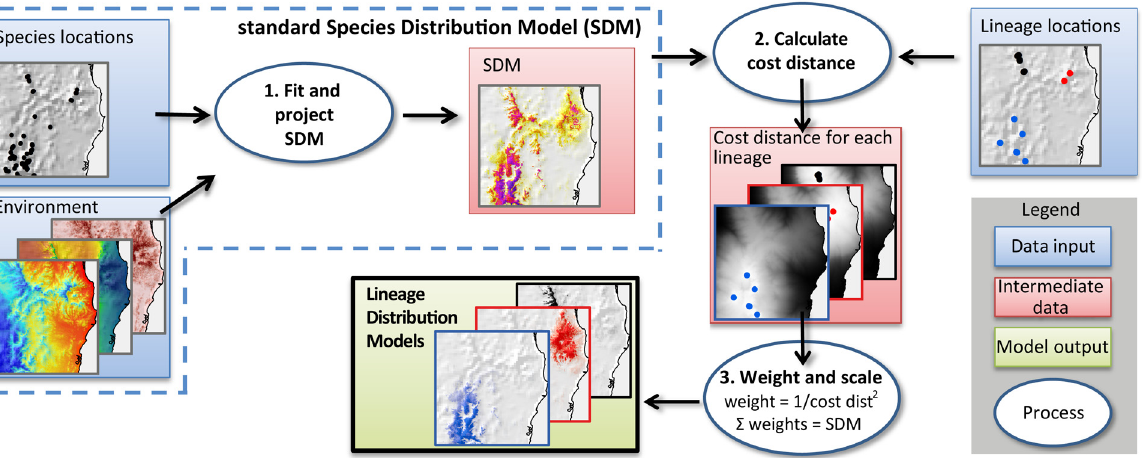
Fig 2. Steps in the lineage distribution model (LDM) method. First a species distribution model is fitted, using established methods (step 1). Then, a cost distance calculation is used to determine, for each pixel, its connection through suitable habitat to known locations of each lineage (step 2). Finally, the cost distance is turned into a weight, and scaled so that for each pixel, the weights for the lineages sum to the species model suitability (step 3). In effect, the species model is partitioned among the known lineages in proportion to their likely level of connectivity to that